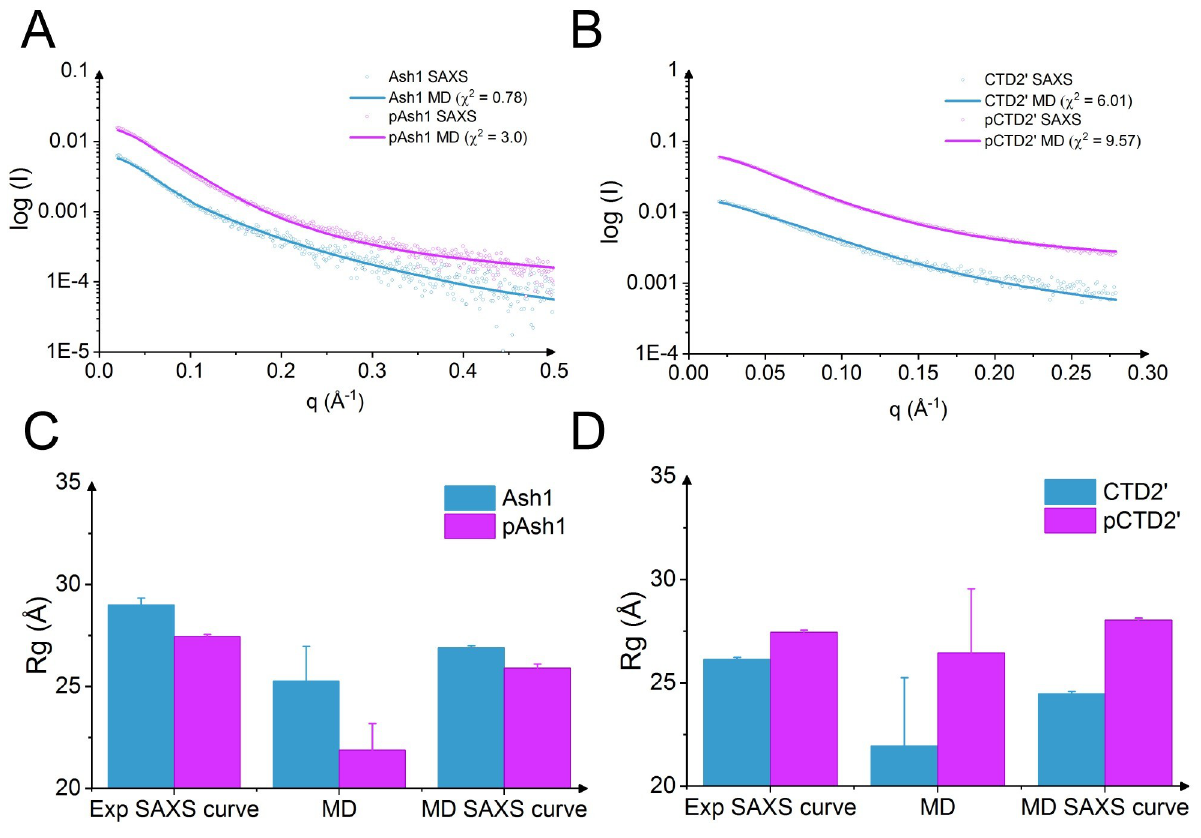
Fig 4. Validation of MD simulations by comparison to SAXS data. Reversely calculated SAXS curves for Ash1/pAsh1 (A) and CTD2’/pCTD2’ (B) obtained at 350 mM NaCl were compared with experimental curves (150 mM NaCl). The radius of gyration from SAXS experiments using extended Guinier analysis (‘Experimental SAXS curve’), directly calculated from MD simulations (‘MD’), and calculated from MD-based SAXS data using Guinier analysis (‘MD SAXS curve’) were compared for Ash1/pAsh1 (C) and CTD2’/pCTD2’ (D).